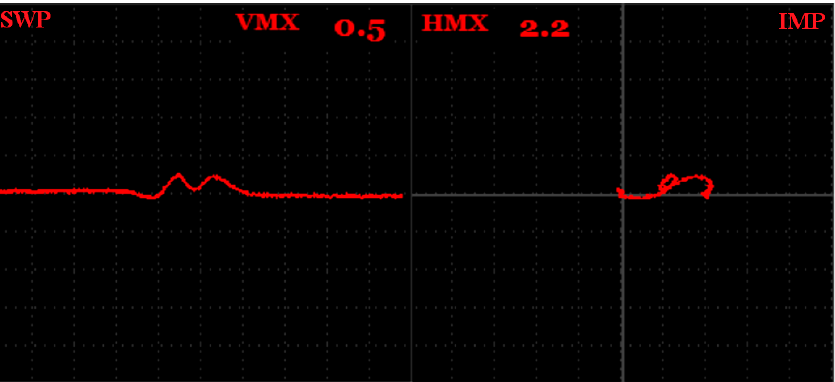
Figure 8. S3 sample, D6 defect signal variation at 60 kHz excitation frequency.